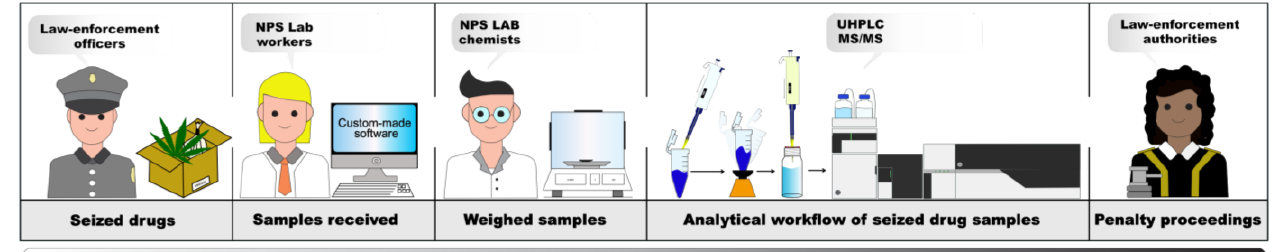
Figure 5. Workflow of the seizure analysis process.